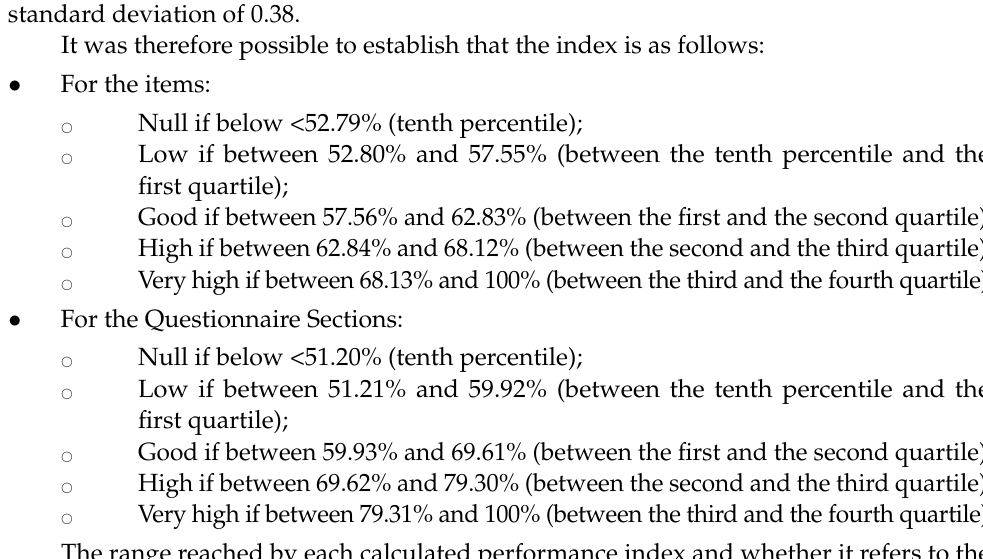
Table 3. Summary of the results regarding the performance indexes and their corresponding ranges.